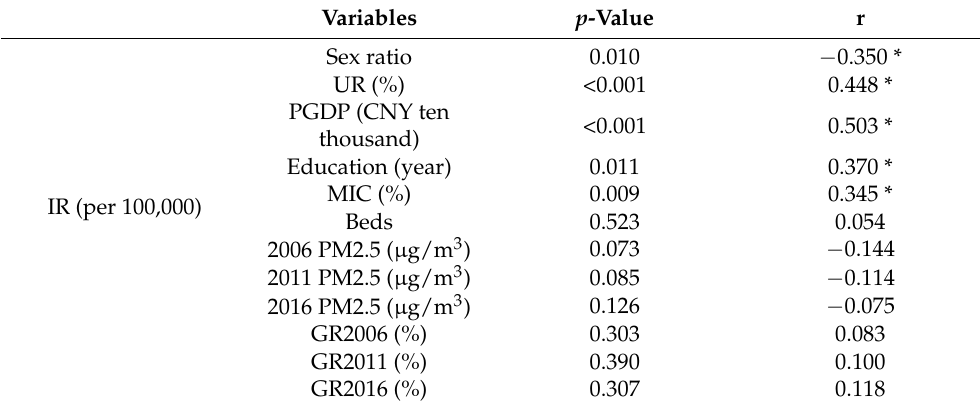
Table 3. Spearman correlation analysis.